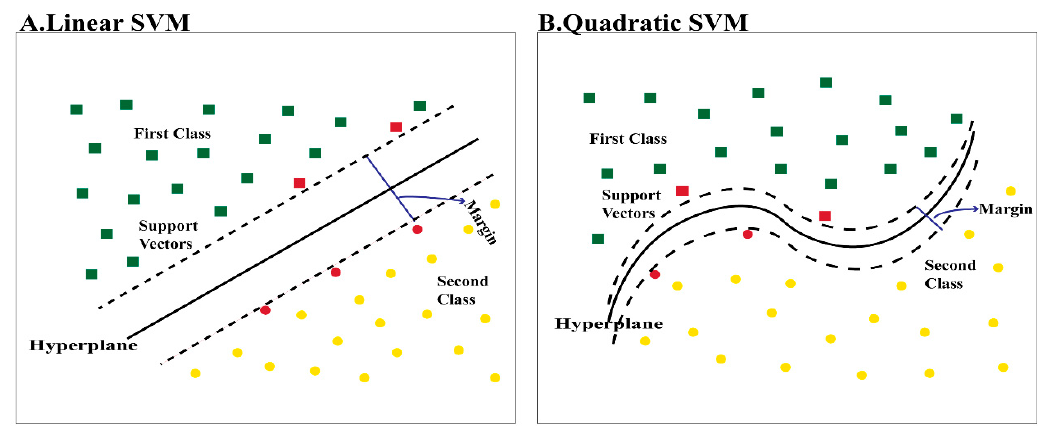
Figure 11. The di ff erence between ( A ) a linear kernal and ( B ) a quadratic Figure 11. The difference between ( A ) a linear kernal and ( B ) a quadratic kernel.